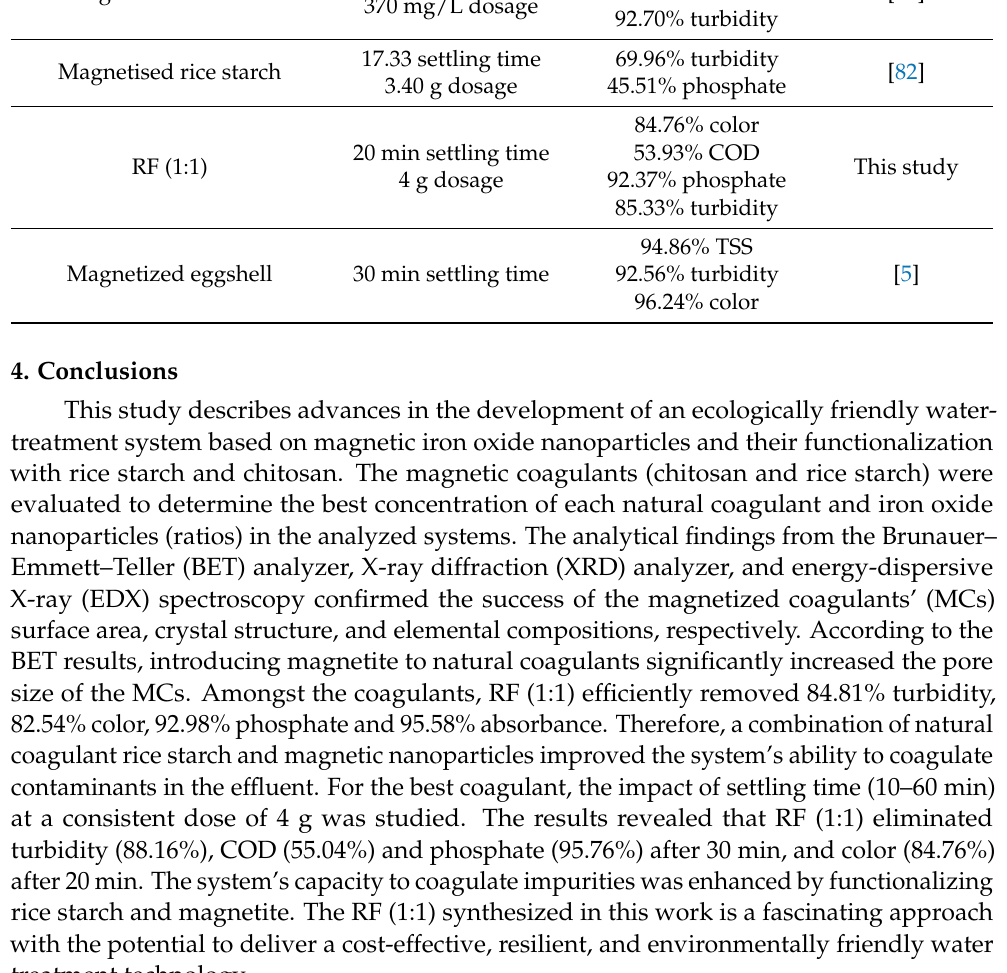
Table 9. Comparative study on various nanocomposites used in wastewater treatment. Magnetized Coagulant Magnetized moringa oleifera 30 min settling time 68.33%